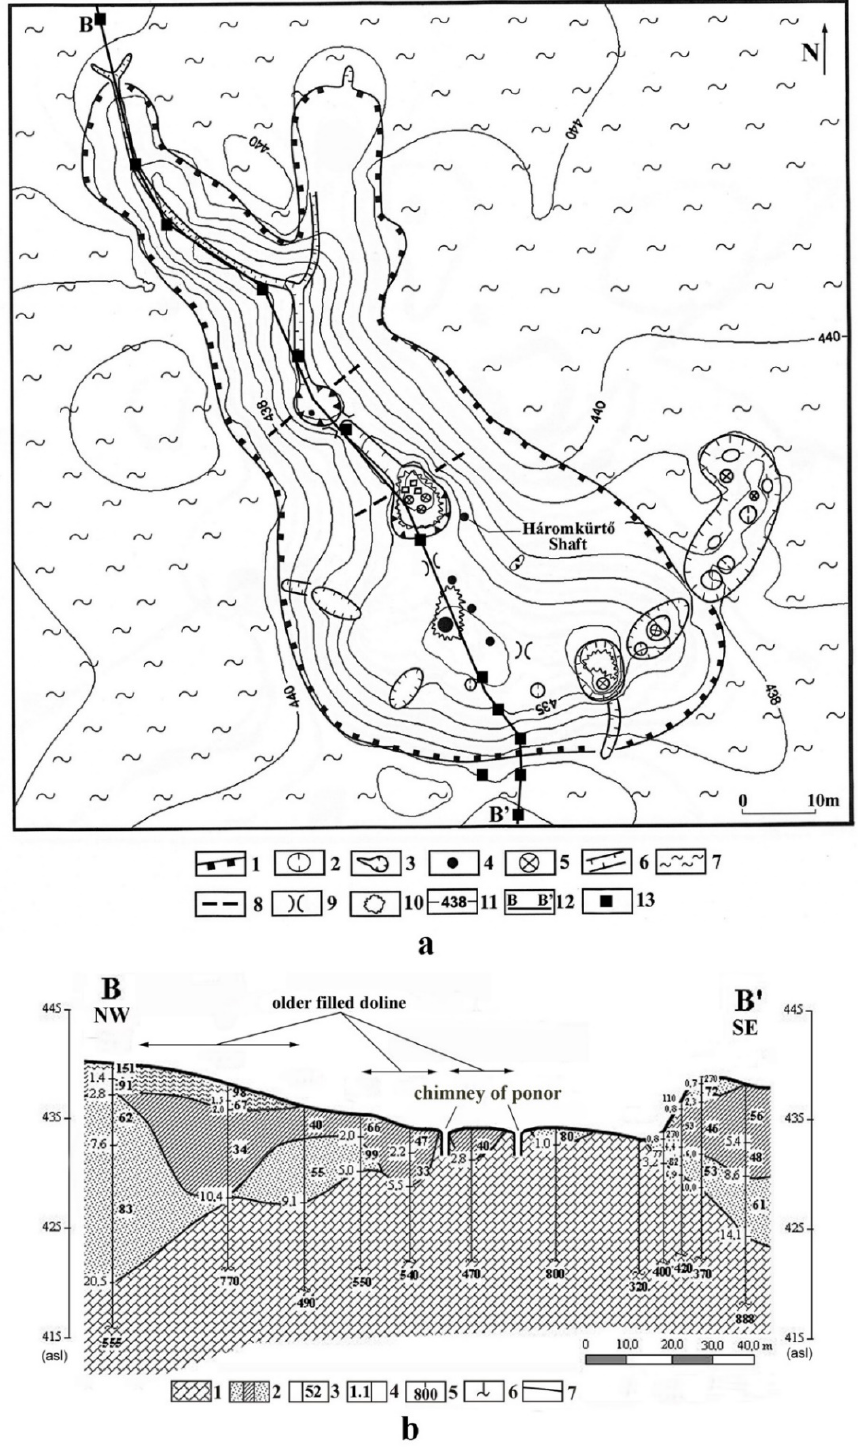
Figure 6. Depression bearing Háromkürtő shaft ( a ) (Tés Plateau, Hungary) and cover thickness condition in its environs ( b ) ([11] modified). Legend: ( a ) 1. margin of DSD, 2. subsidence doline, 3. ponor, 4. pit, shaft, 5. passage in the cover, 6. creek, 7. surrounding terrain, 8. rock boundary, 9. saddle, 10. rock outcrop, 11. contour line, 12. track of profile, 13. VES measurement site, ( b ) 1. limestone, 2. superficial deposits of various grain, 3. geoelectric resistivity of series (Ohmm), 4. base depth of geoelectric series (m), 5. geoelectric resistivity of bedrock (Ohmm), 6. approximate penetration depth of VES measurement, 7. boundary of geoelectric series.